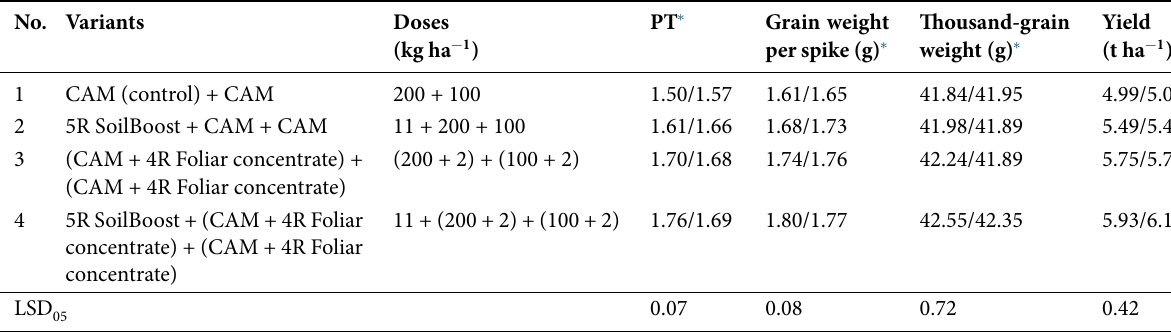
Table 4 e winter wheat yield of the ‘Kubus’ and ‘Mulan’ cultivars as influenced by the fertilizer system. No.